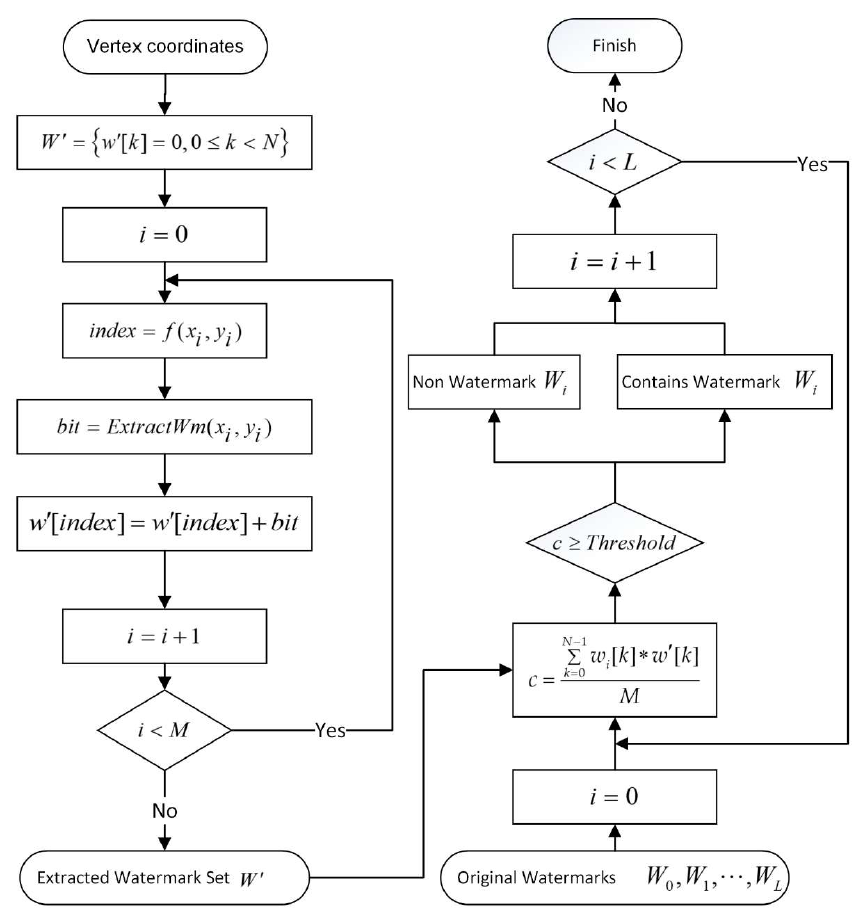
Figure 6. The flowchart of multiple watermark extraction and detection.